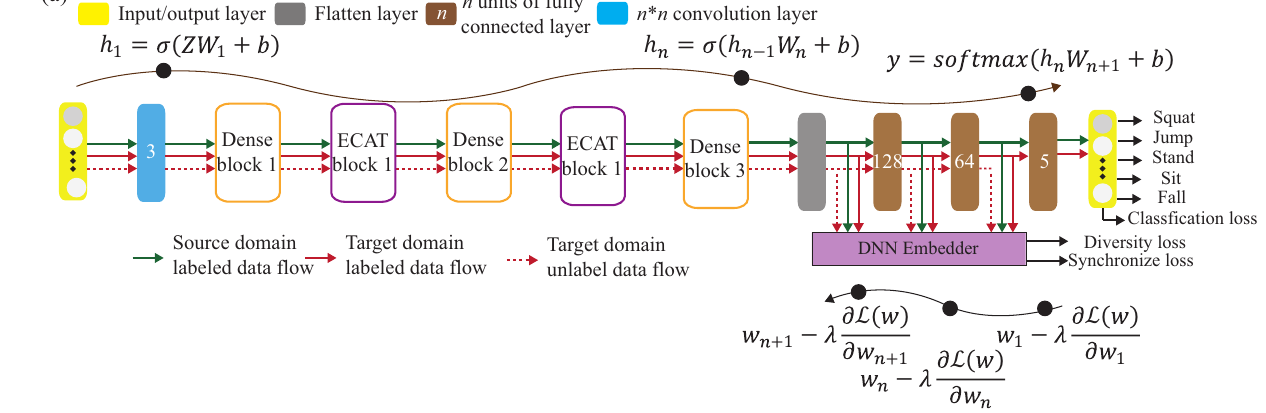
Figure 15. Example of the associate knowledge fine-tuning